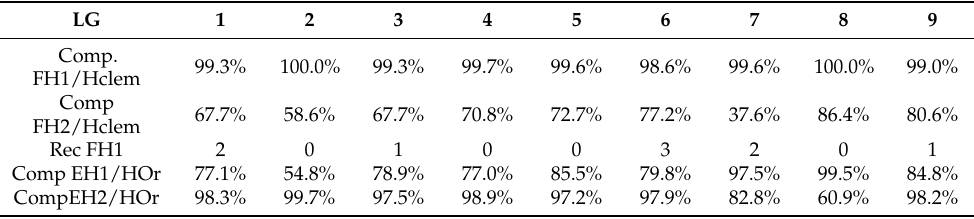
Table 4. Compatibility of each haplotype chromosome of, respectively, ‘Fortune’ (FH1, FH2) and ‘Ellendale’ (EH1, EH2) with the haplotypes of clementine and sweet orange based on the average similarity of ten marker windows (average of the best percentage of similarity per window for each ‘Fortune’ and ‘Ellendale haplotype). Rec FH1: number of recombinations in the FHI haplotype. LG